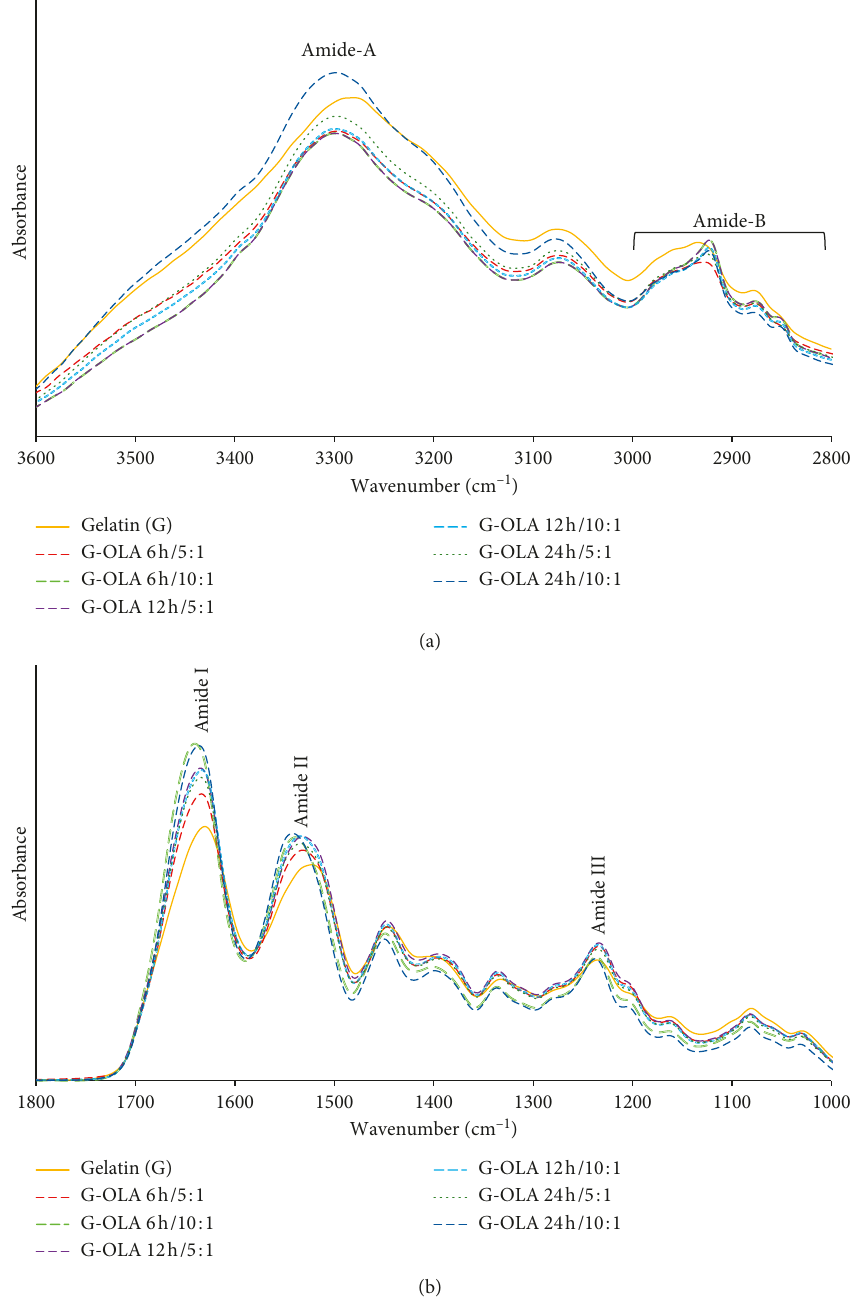
Figure 3: FTIR spectra in the wavenumber region of 3600–2800cm − 1 (a) and 1800–1000cm − 1 (b) of fish skin gelatin modified with OLA prepared using different oxidation times and using various OLA-to-free amino group molar